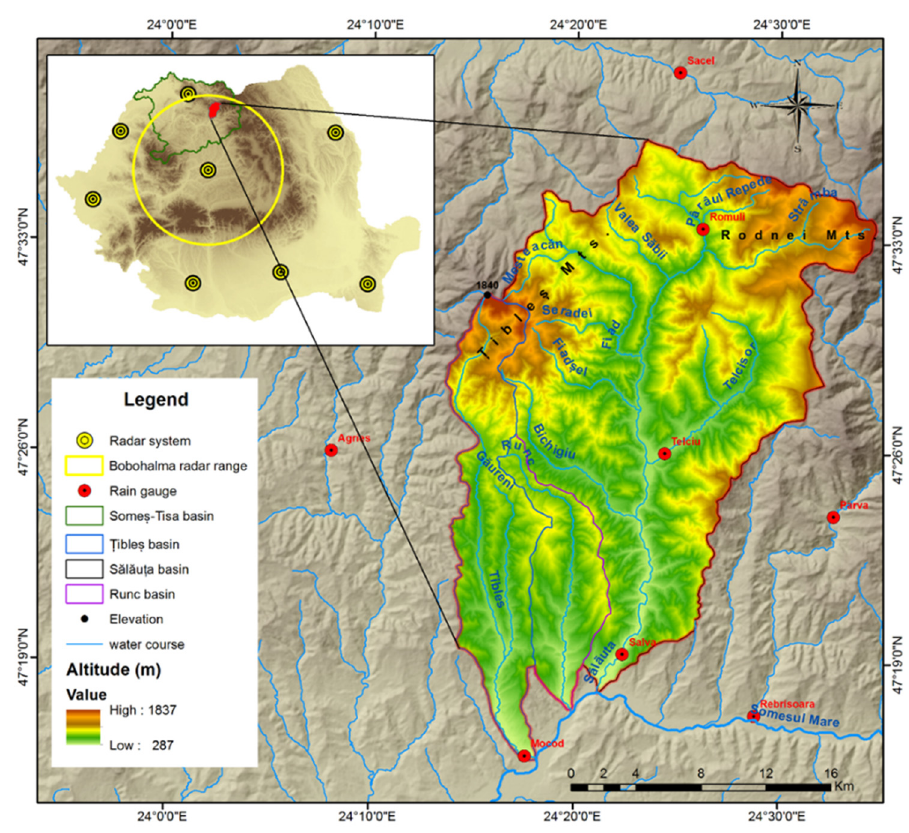
Figure 1. Study area and position of Bobohalma radar.